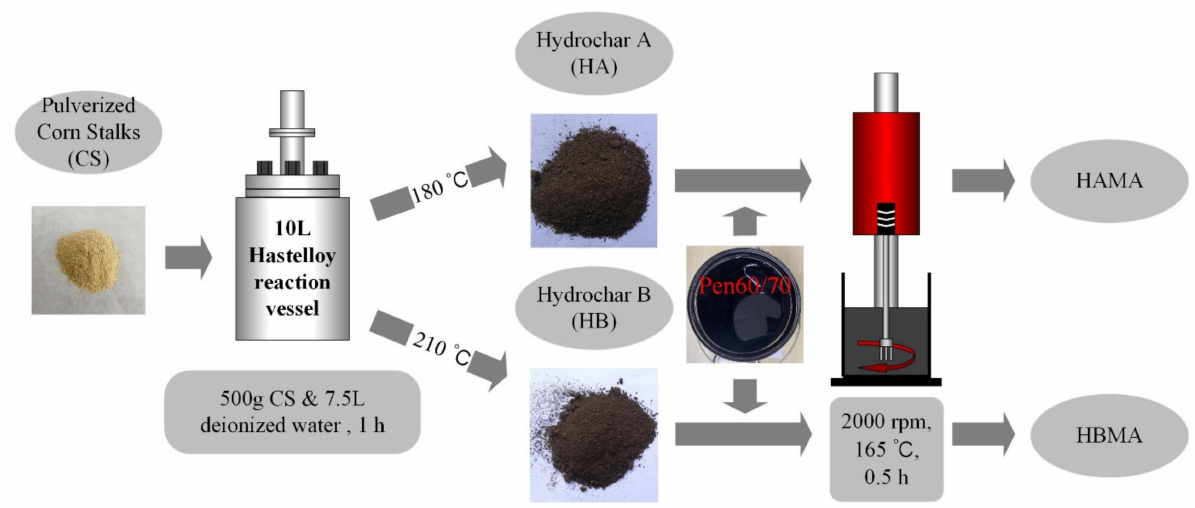
Figure 2. Preparation of hydrochar-modified asphalt